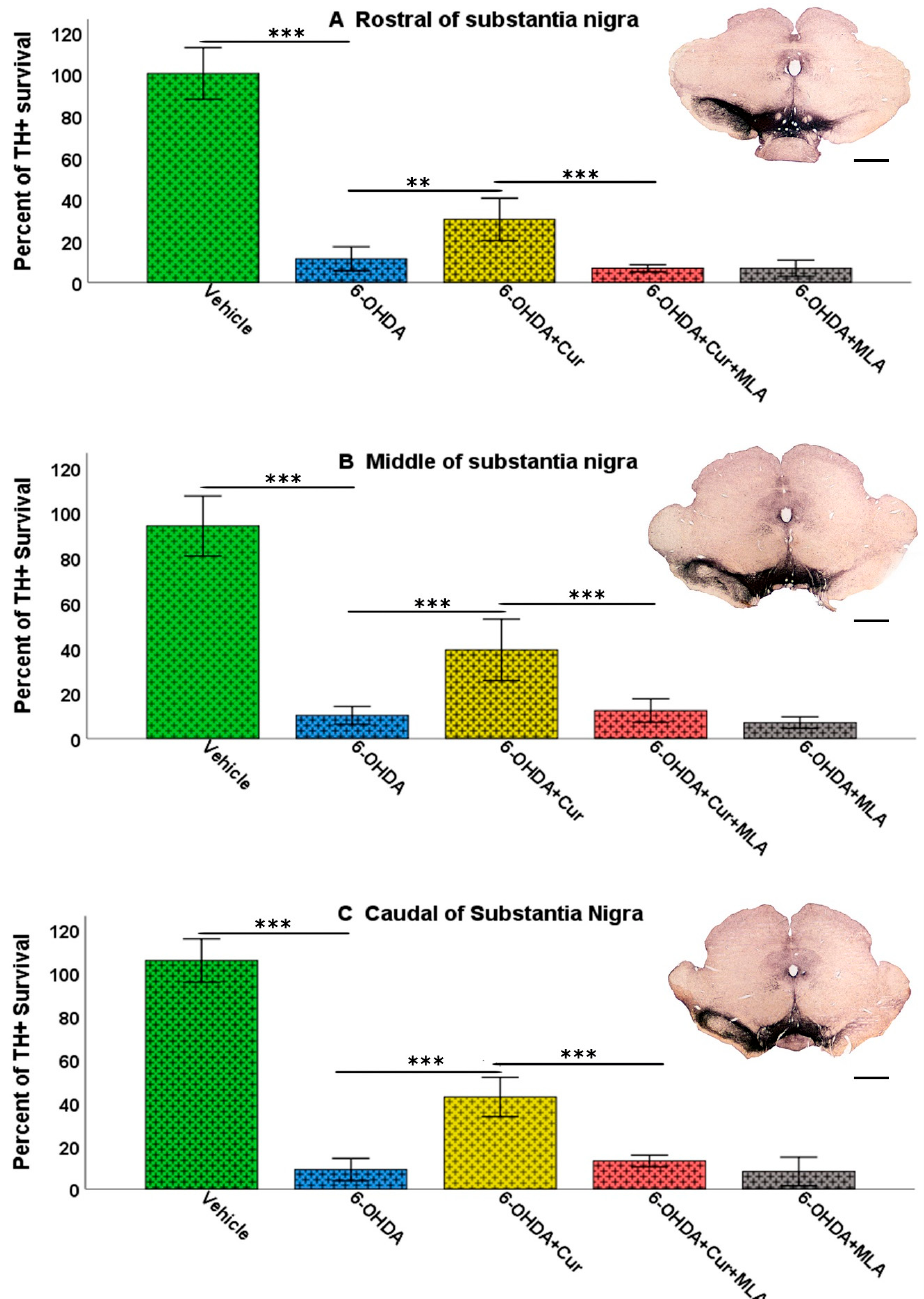
Figure 5. Stereological assessment of the total numbers of TH-positive cell bodies in the SNpc at all three levels: rostral, middle, and caudal. Multiple intra-striatal 6-OHDA injections caused a dramatic loss of TH-positive neurons in the SNpc compared with the vehicle-treated animals (ANOVA, rostral, middle, caudal, and total, p < 0.000 ***, at all levels). The neuroprotective e ff ect of curcumin, through an α 7-receptor mediated mechanism, was marked in the group treated with curcumin at all rostro-caudal levels: rostral ( A ); middle ( B ); and caudal ( C ) in comparison with the 6-OHDA-treated group (ANOVA, rostral p < 0.003 **, middle p < 0.000 ***, and caudal p < 0.000 ***). MLA, an α 7-receptor blocker, reversed the protective e ff ect of curcumin in the 6-OHDA + Cur + MLA group (ANOVA, p < 0.000 *** at all levels). The antagonist MLA had no e ff ect on its own, as indicated by the results from the 6-OHDA + MLA group, which exhibited no statistical di ff erence from the 6-OHDA + Cur + MLA group or 6-OHDA-injected rats (ANOVA, NS, at all levels). Scale bar = 1